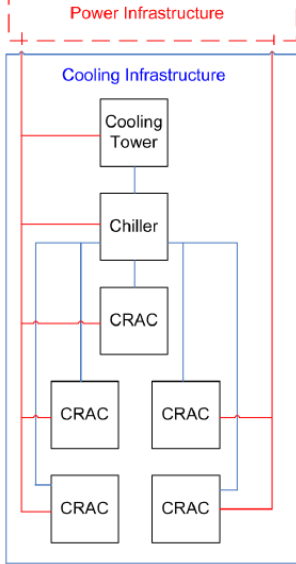
Figure 21. Cooling connections to power the infrastructure.